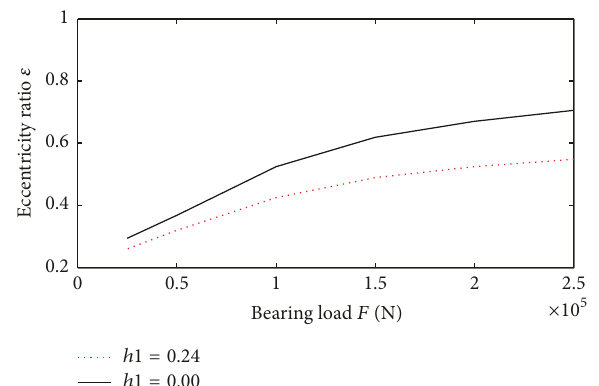
Figure 8: Variation of journal eccentricity ratio with bearing load.